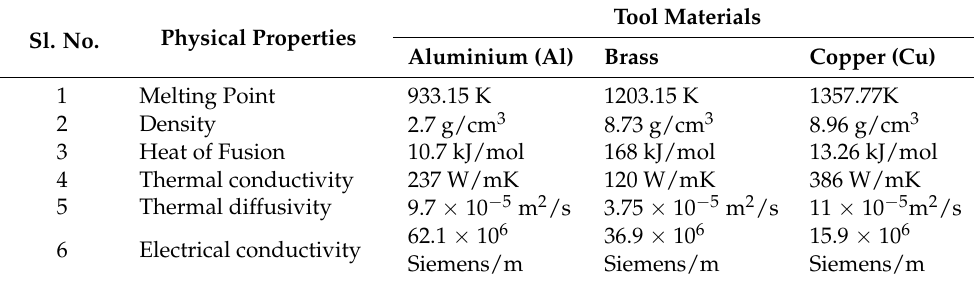
Table 4. The physical properties of Aluminium, Brass and Copper tool